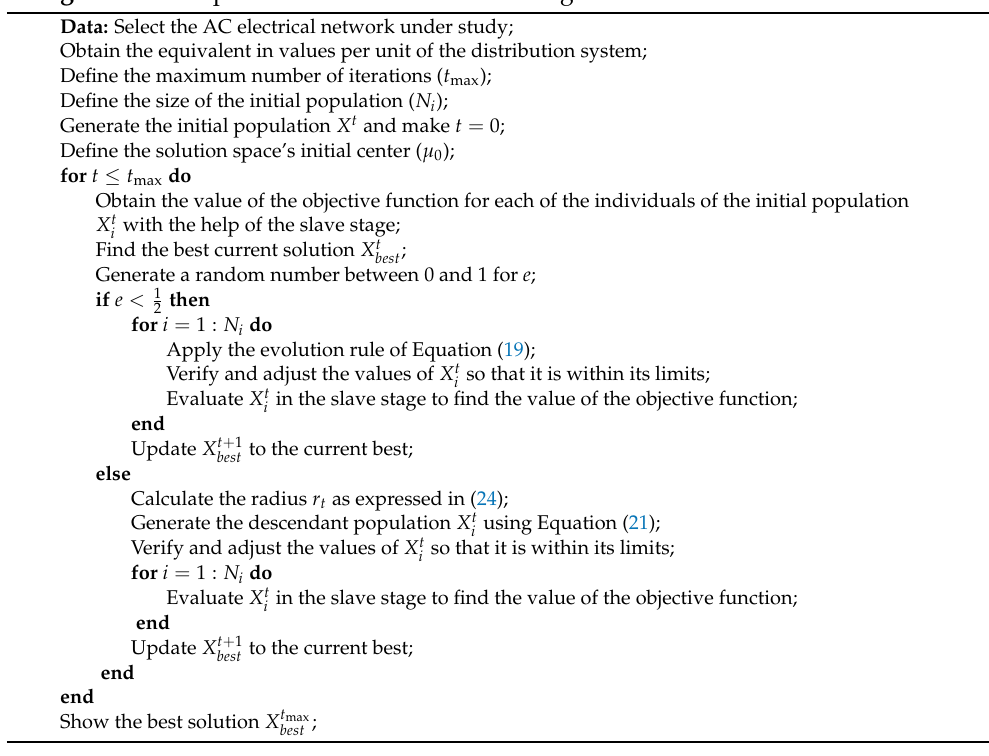
Algorithm 1: Implementation of the MGbMO